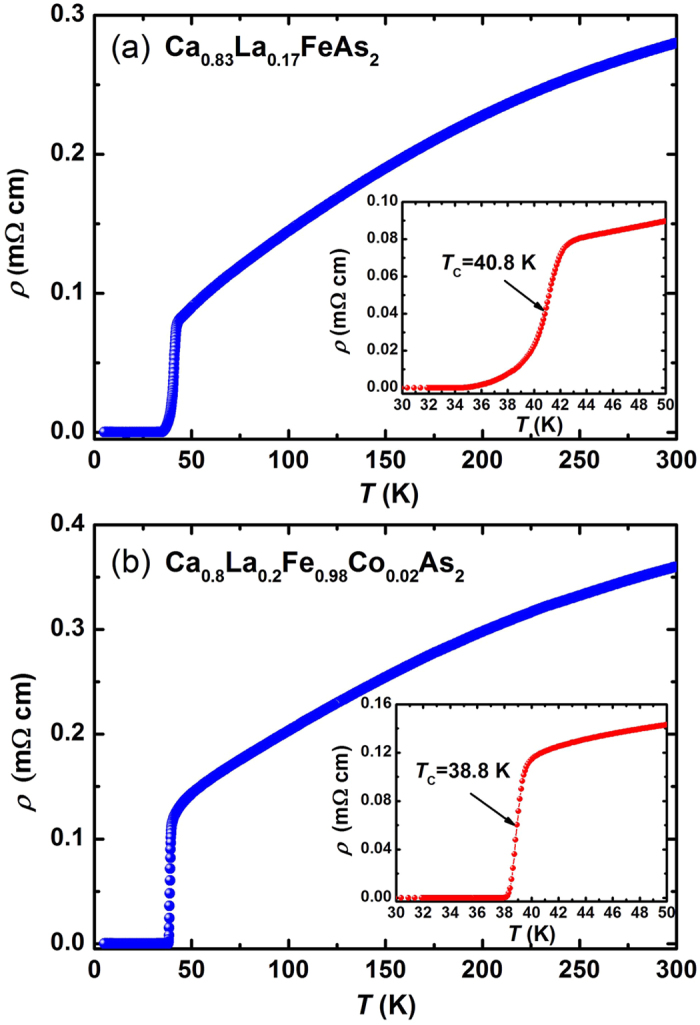
Temperature dependence of the in-plane electrical resistivity ρ(T) for (a) Ca0.83La0.17FeAs2 and (b) Ca0.8La0.2Fe0.98Co0.02As2 single crystals at zero field. The insets of (a) and (b) show an enlarged view of resistivity near the superconducting transition, Tc was determind by the 50% normal state resistivity ρn.